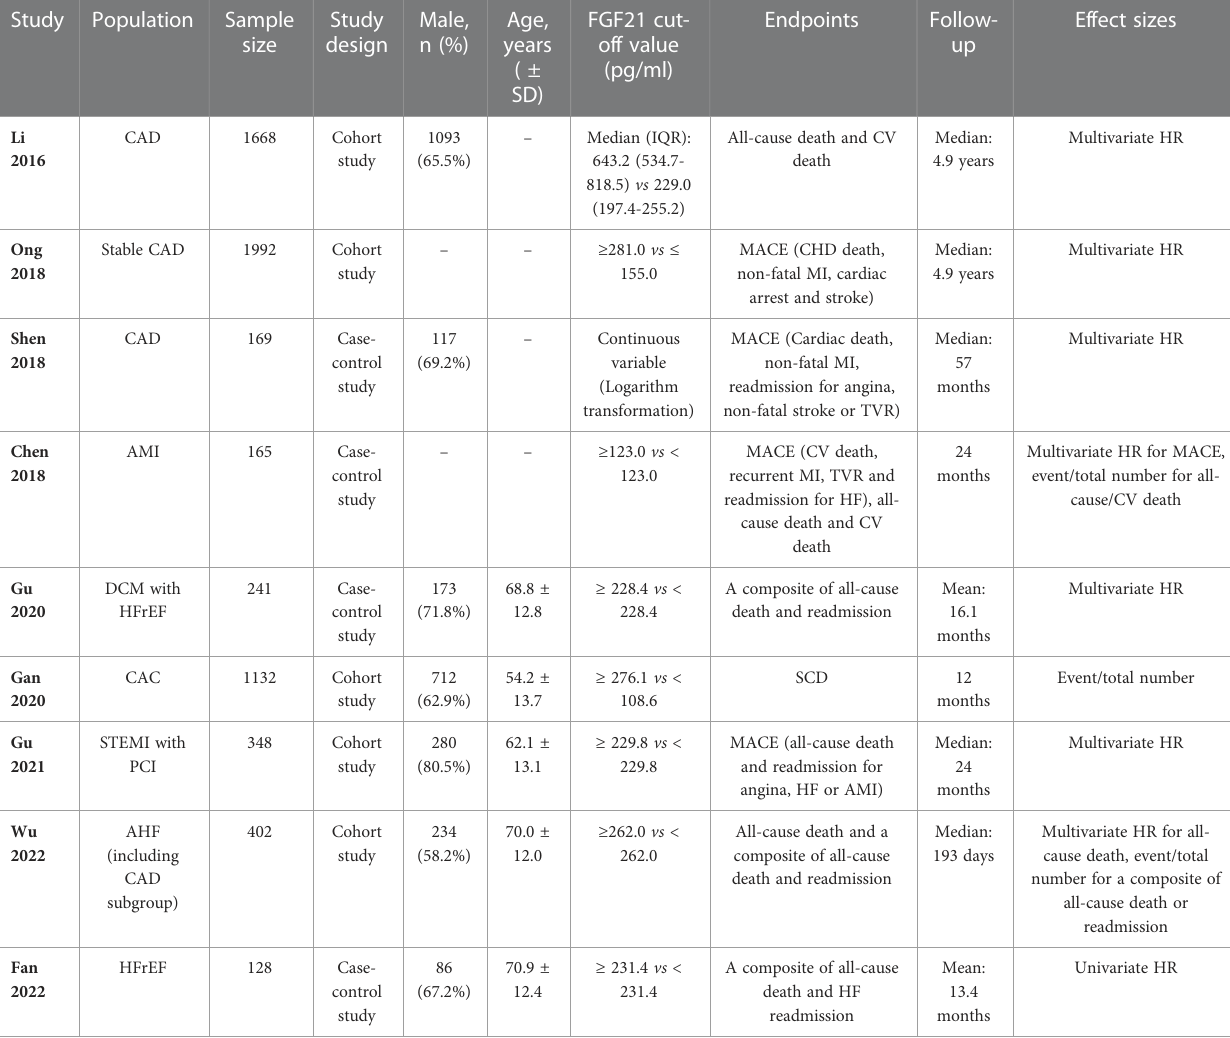
TABLE 1 Characteristics of studies included in the